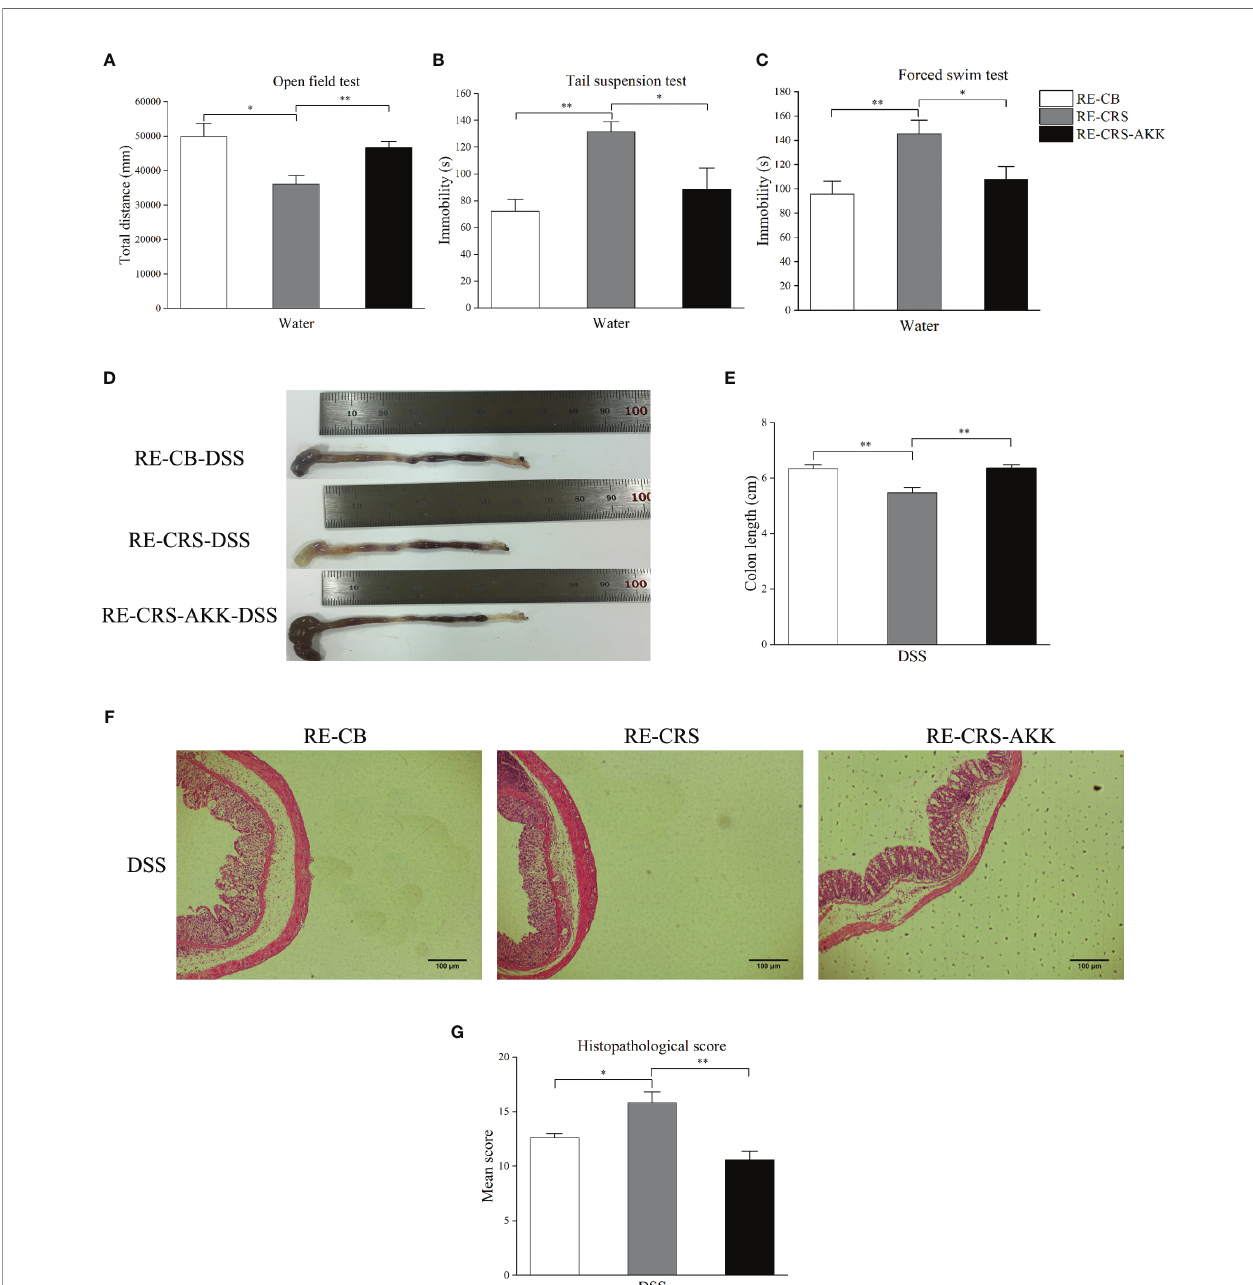
FIGURE 7 | A. muciniphila supplementation alleviated depression-like behavior and colitis aggravation in recipient mice. (A – C) Depression-like behavior in recipient mice was alleviated by oral A. muciniphila supplementation by behavioral tests (n = 6). (D) Representative colon photographs from mice receiving DSS treatment. (E) Colon length recorded at time of sacri fi ce (n = 8). (F) Representative pathological photographs of colonic injury in mice receiving DSS treatment (magni fi cation ×40, scale bar: 100 m m). (G) Colonic injury score assessed by histopathological score based on H&E staining in recipient mice (n = 4 – 5). *p < 0.05, **p <